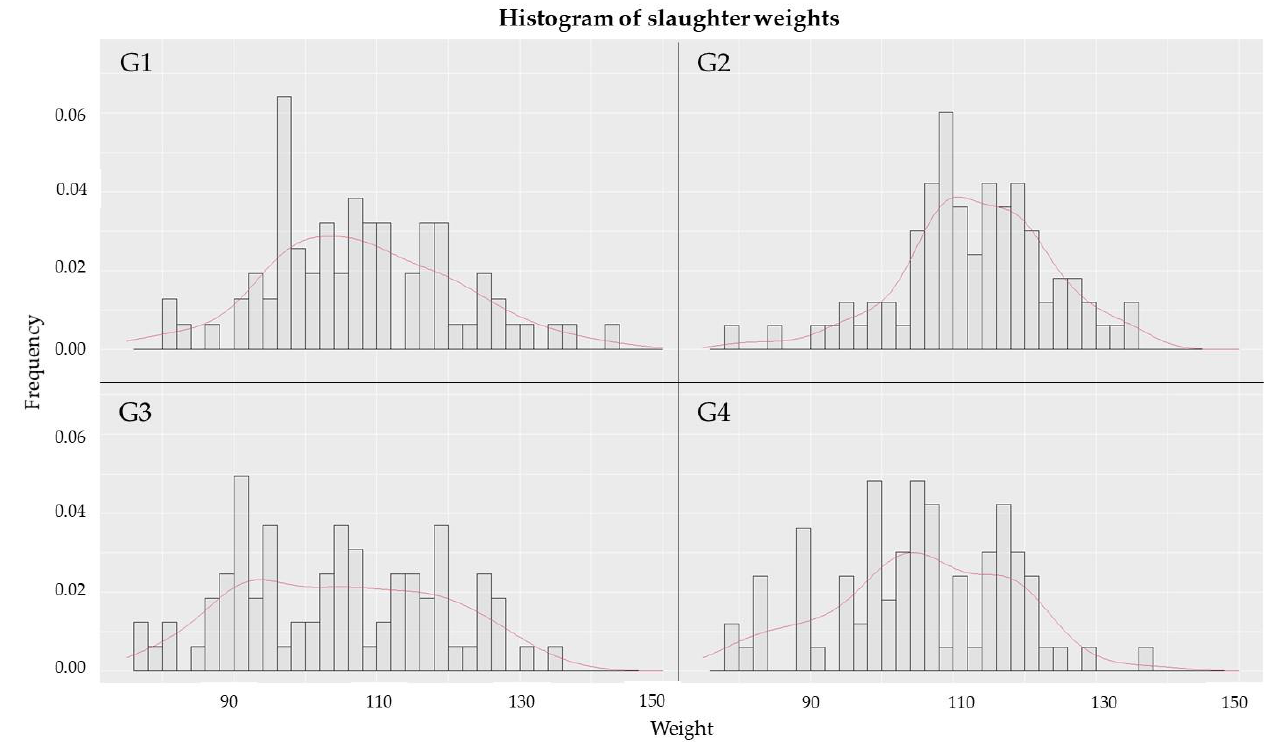
Figure 2. Weight histograms for G1, G2, G3 at 151 days and for G4 at 145 days of age. Regarding the assessment of average daily weight gain (ADWG), in Table 3 it is possible to verify the performance of the different groups in the nursery, finishing phase and from 25 days (weaning) to slaughter, at 151 days of age for G1, G2 and G3, and 145 days of age for G4. Table 3. Average daily weight gain (ADWG) of the four groups in the nursery, finishing phase, and weaning to slaughter